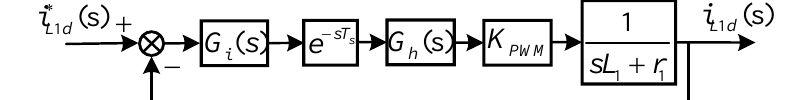
Figure 4. Schematic diagram of the current loop.